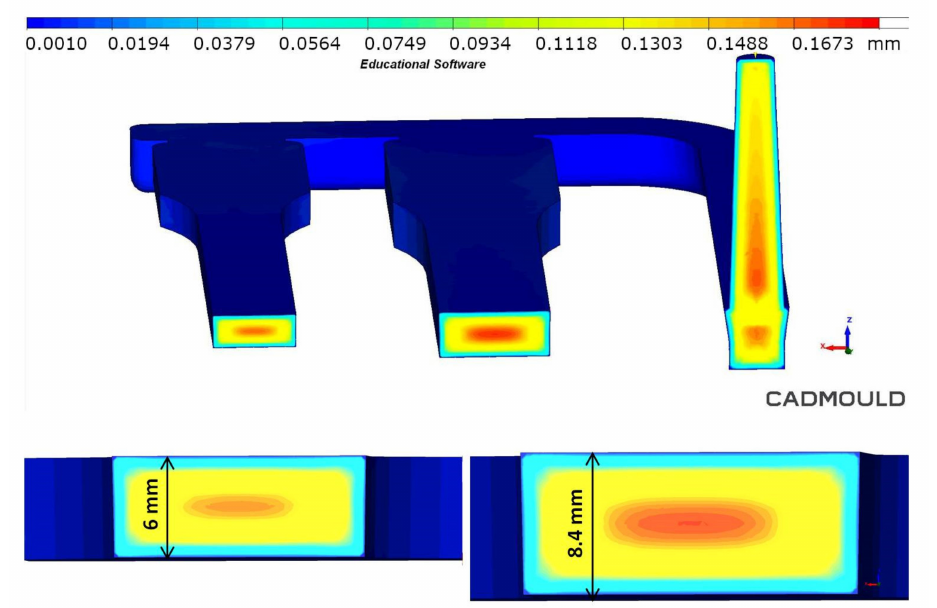
Figure 21. Simulated pore size distribution in the cross-section of 6 mm and 8.4 mm thick polyamide test specimens.